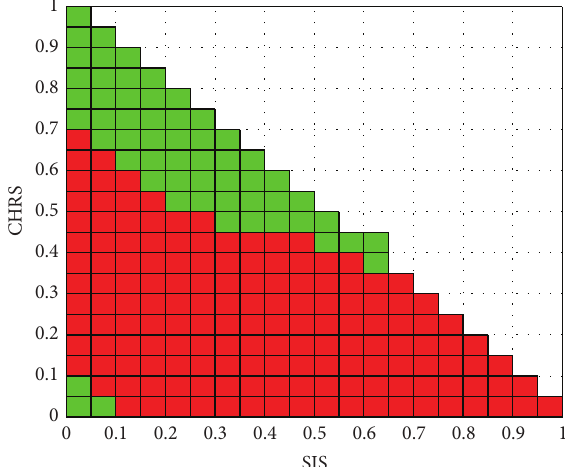
Figure 13: Cluster representation of the failure domain (red) and safety domain (green) for the sequence [ INI SIS CHRS IGNI ] in terms of controllable events, axes scaled between 0 and